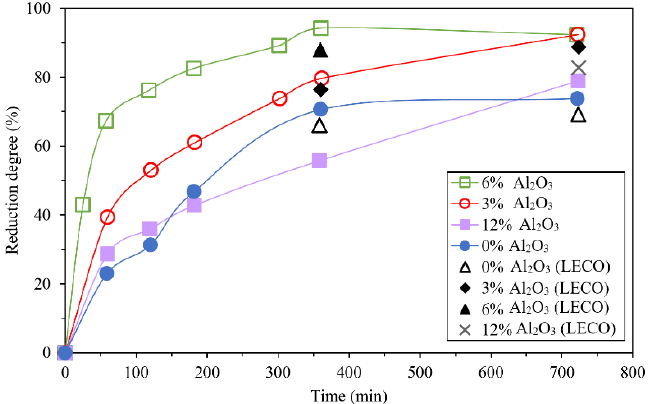
Figure 15. Effect of alumina content on reduction of Fe 3 O 4 –Al 2 O 3 system at 850 °C by CO–CO 2 gas mixture (80% CO) [52] “modified”.